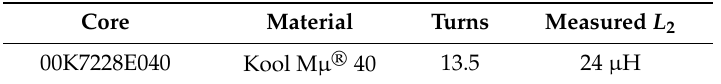
Table 5. Characteristics of the realized inductor.